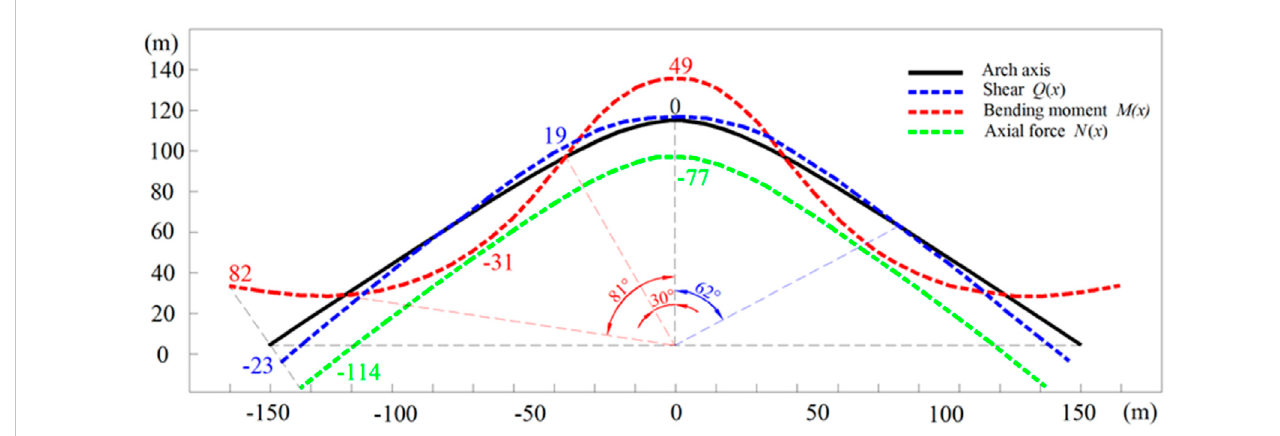
FIGURE 6 Distribution rule of internal force of SRPA (Unit of bending moment: kNm; Unit of shear and axial force: kN).